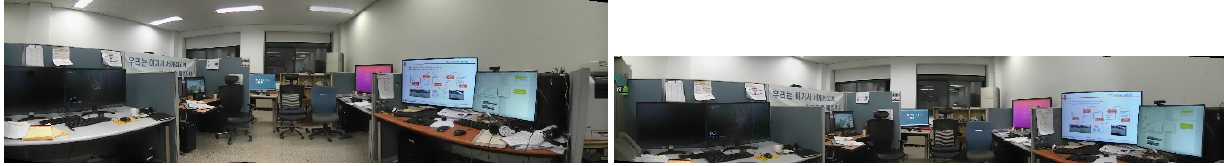
Figure 13. Panoramas from side: left (5800 × 1600 = 180° × 56°) and right (5800 × 1000 = 180° × 36°).